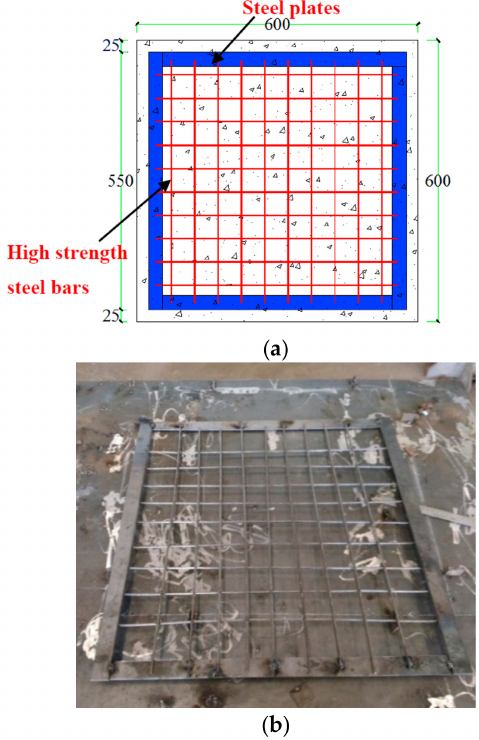
Figure 4. Detailed information of the steel skeleton of the specimen. ( a ) Sketch of reinforcement; ( b ) Detailed photograph of steel